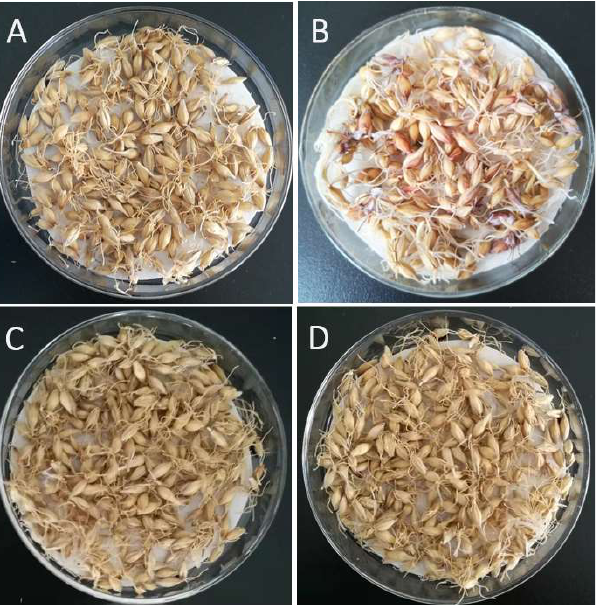
Figure 5. Visual aspects of uninfected malt grains (UMG) ( A ), mixed malt grains (MMG) ( B ) and MMG treated with 0.1 g/kg of chitosan ( C ) or 0.5 g/kg of chitosan ( D ).